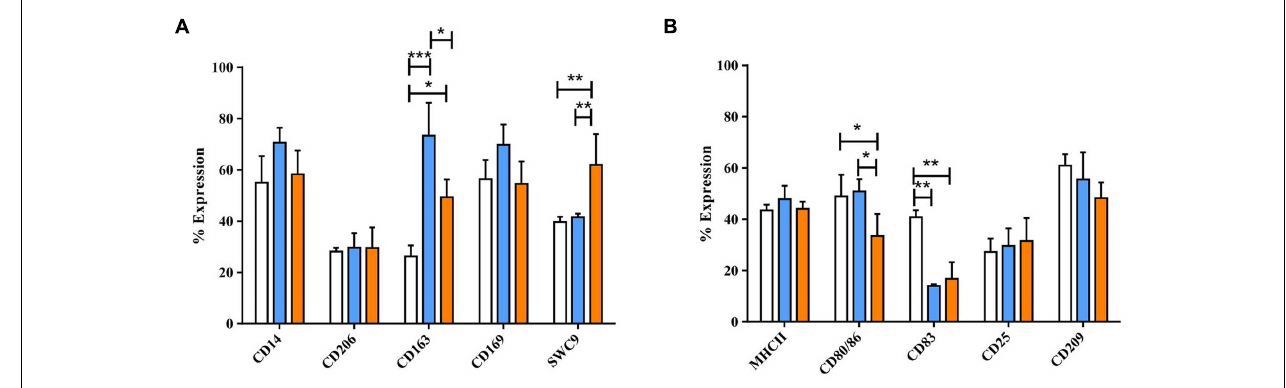
FIGURE 2 | Phenotypic analysis of dexa and IL-10 treated MoMØs. Freshly isolated peripheral porcine monocytes were treated with M-CSF for 4 days to obtain MoMØs. MoMØs were treated with dexa (blue) or IL-10 (orange) or left unstimulated (unfilled bars). After a further 24 h MoMØs were harvested and surface stained for pathogen recognition receptors/lineage markers (A) or antigen presentation/co-stimulatory molecules (B) for flow cytometric analysis. Data represent mean percentage of cells expressing markers + SD. One-way ANOVA was used to assess significance followed by Bonferroni’s multiple comparison test ∗∗∗ p < 0.0001, ∗∗ p < 0.001, ∗ p <